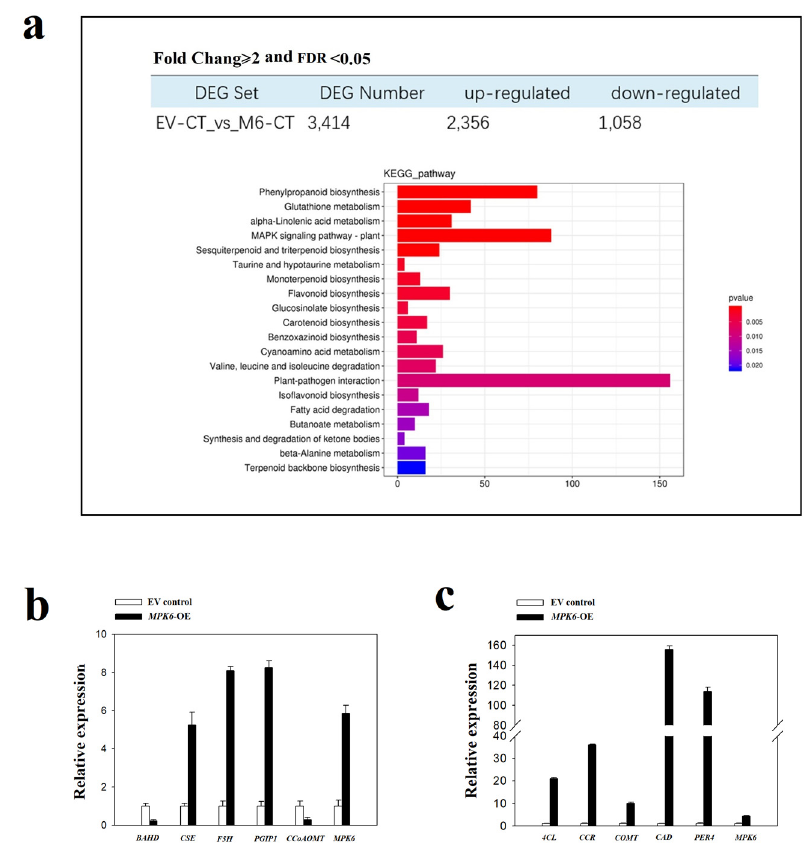
Figure 5. RNA-seq and quantitative real time (qRT)-PCR analysis. ( a ) expression pattern of genes affected by FaMPK6 over-expression. Detached fruit at the W stage were transiently transformed with A. tumefaciens carrying an empty vector or FaMPK6 driven by the pSuper promoter. RNA-seq analysis was performed of extracts from fruit at day 4 after transformation. Genes regulated by FaMPK6 were identified as having differences in transcript levels between the empty vector control (EV) and FaMPK6 over-expressing fruits at a fold change ≥ 2 and a false discovery rate (FDR) < 0.05. RNA-seq analysis was performed of pools of 10 individual fruit, with three biological replicates. ( b , c ) qRT-PCR analysis (a pool of 10 individual fruit with three biological replicate) showing the expression pattern of several marker genes implicated in phenylpropanoid metabolism as affected by FaMPK6 over-expression. ( b ) genes with fold changes < 10; ( c ) genes with fold changes > 10. Error bars are mean ± SD of three biological